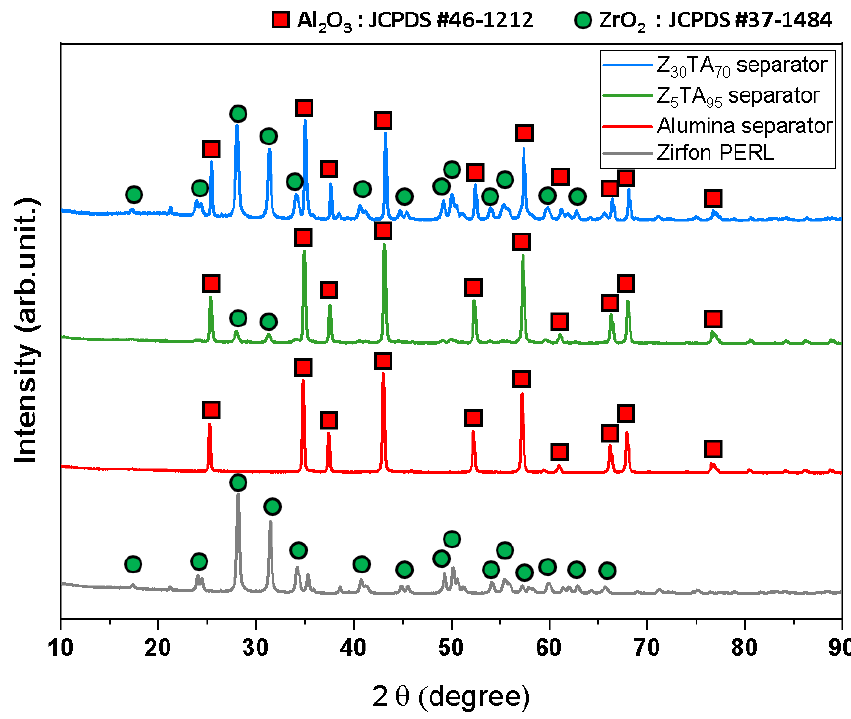
separator membrane and Zirfon ® . Figure 1. XRD patterns of commercial Zirfon ® and prepared separator membranes.